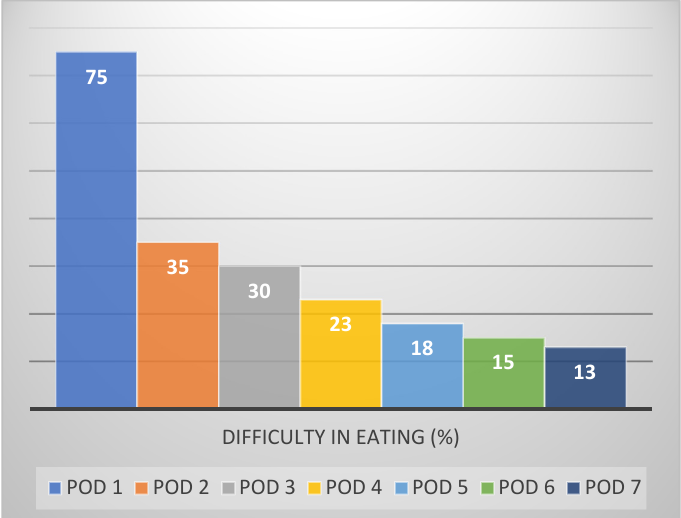
Figure 2. Percentage of individuals experiencing difficulty in eating (>2) over time.